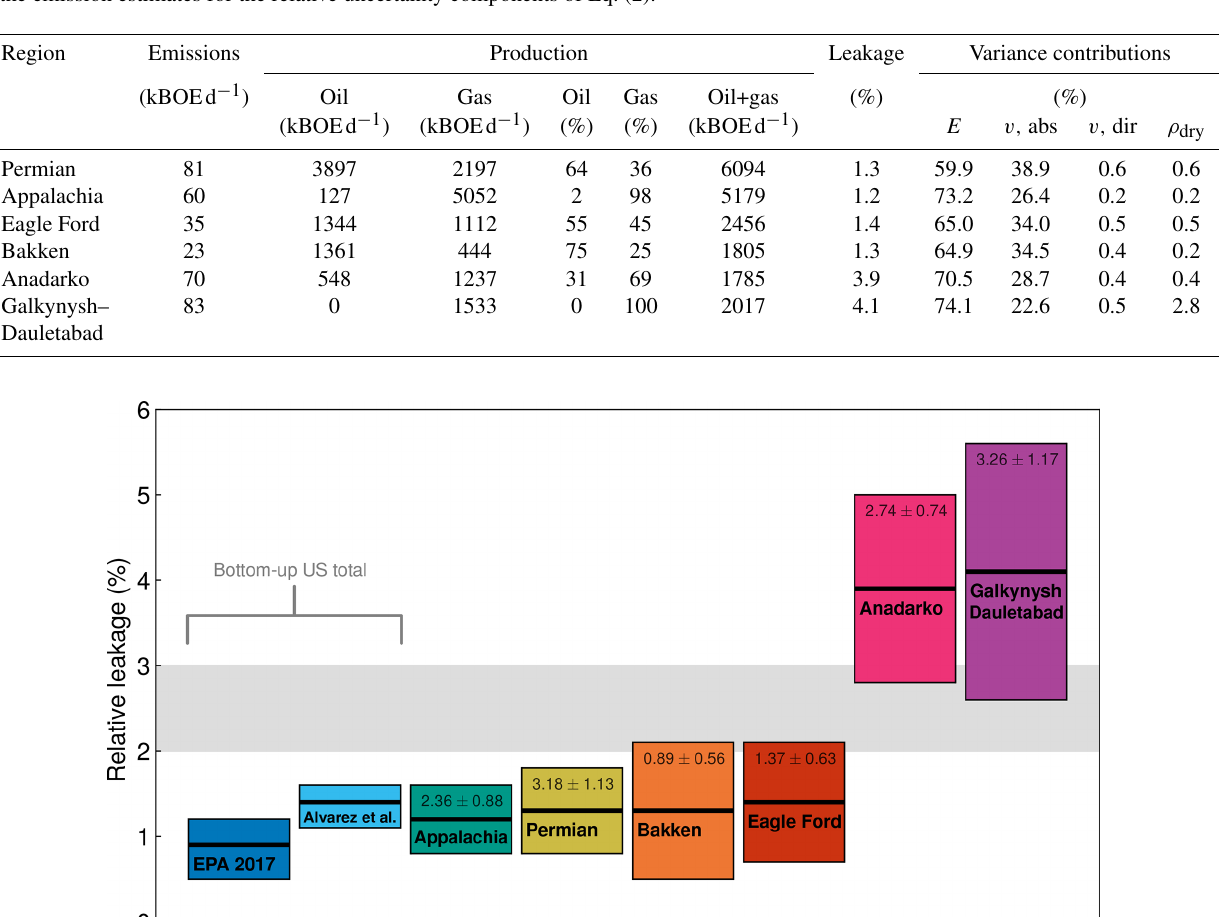
Figure 13. Summary of the results for the different regions analysed in this study and a comparison to bottom-up estimates for the entire United States. All leakage rates are calculated relative to combined oil and gas production in terms of energy content. The respective absolute emissions (Mtyr − 1 ) are shown in the upper area of the bars for the individual regions. The assumed break-even range for immediate climate benefit is shown in